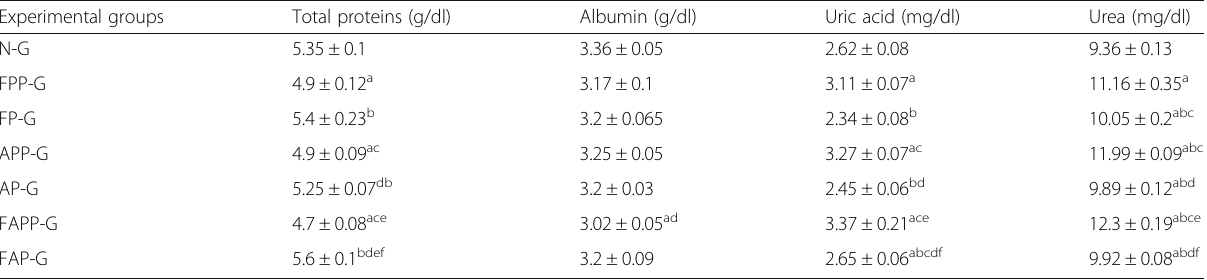
Table 1 The levels of total proteins, albumin, uric acid, and urea in the serum of offspring rats exposed to NaF or AlCl 3 alone and in combination through the pre- or/and postnatal stages until 70 days Experimental groups